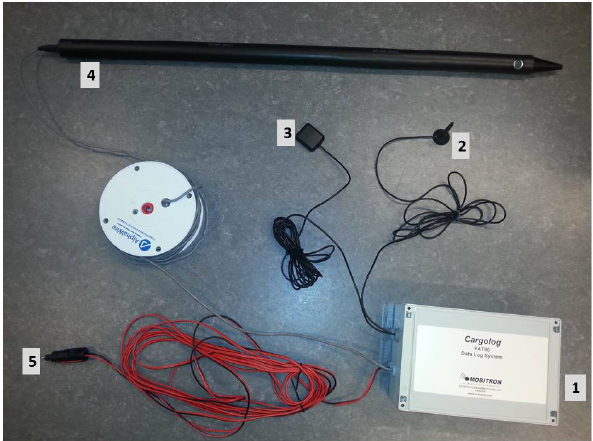
Figure 4. Smart box system assembly: ( 1 ) Smart box protected with metal case; ( 2 ) GPRS/GSM antenna; ( 3 ) GPS antenna; ( 4 ) temperature and humidity measuring sensor probe; ( 5 ) power cable.